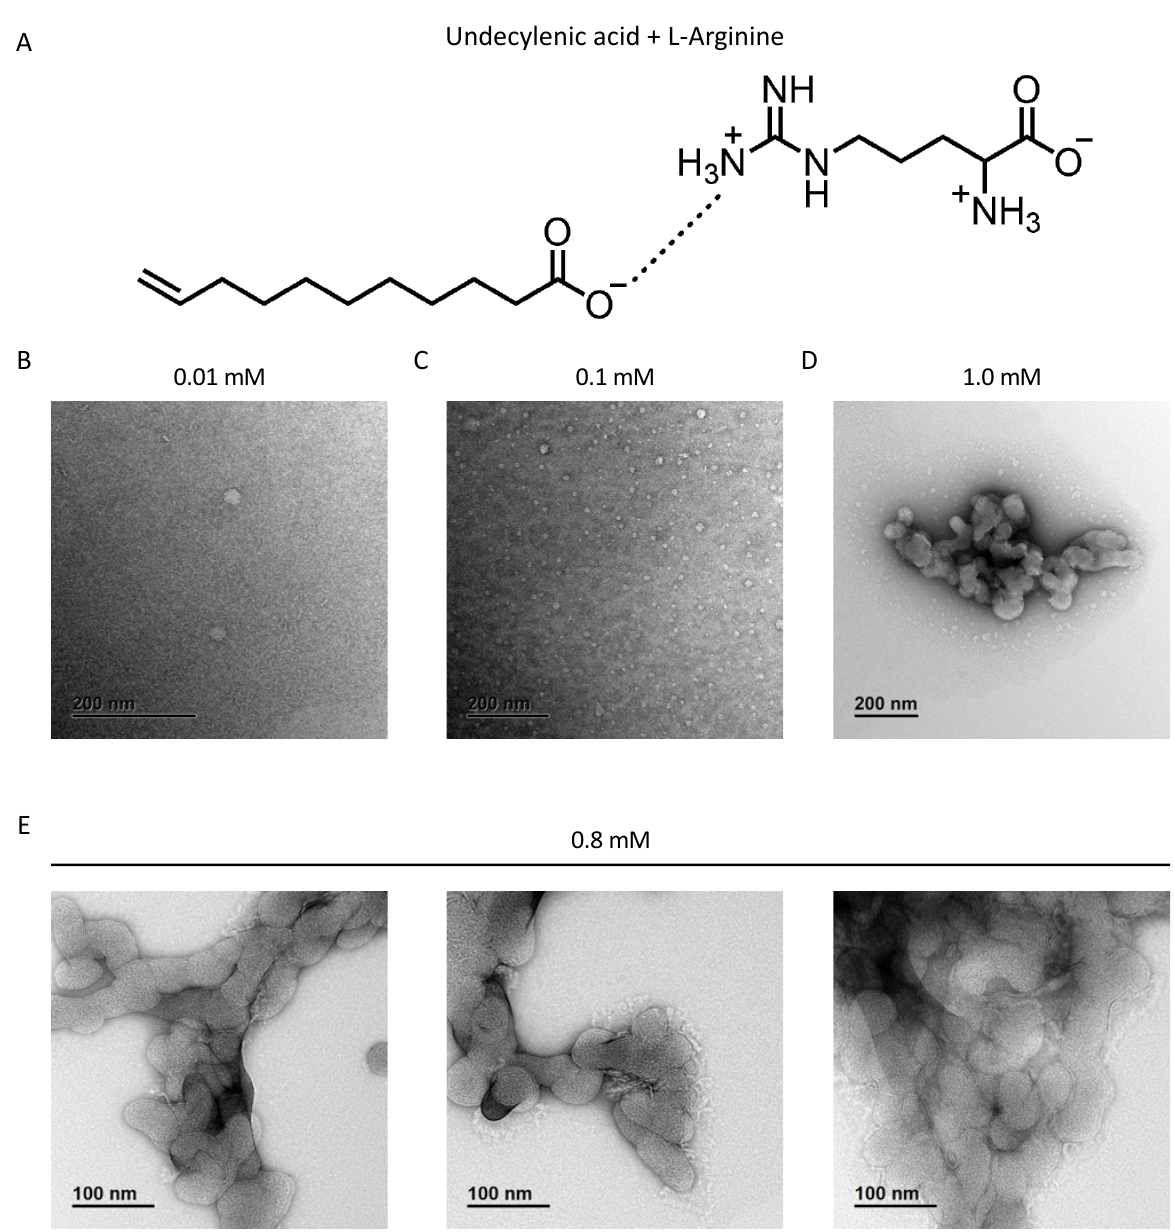
Figure 1. Biophysical characterization of GS-1. ( A ) Schematic representation of the structure and Figure 1 . Biophysical characterization of GS-1 . (A) Schematic rep-resentation of the interactions of GS-1 components. ( B – E ) TEM of GS-1 was performed at ( B ) 0.10 mM (150,00 × ), structure and interactions of GS-1 components. (B-E) TEM of GS-1 was per-formed at (B) ( C ) 0.10 mM (100,000 × ), ( D ) 1.0 mM (80,000 × ), and ( E ) 0.80 mM (200,000 × 0.10 mM (150,00 × ), (C) 0.10 mM (100,000 × ), (D) 1.0 mM (80,000 × ), and (E) 0.80 mM (200,000 × ).